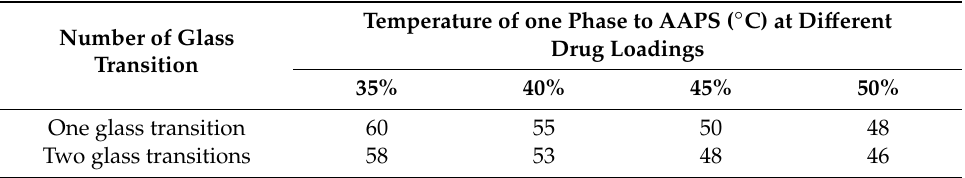
Table 2. The summary of AAPS boundary at drug loading 35%, 40%, 45% and